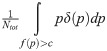
Stimuli and visual filters.a) Examples of RGB natural color images from the database. b) Set of N = 50 filters obtained after digitizing to 1 bit the luminance (L+M) coordinate. The actual bandwidth occupancy of the set (1Ntot∫f(p)>cpδ(p)dp) turns out to be slightly higher (0.06) than the imposed limit W (0.05). c) Set of N = 50 filters obtained after digitizing to one bit the l (L/(L+M)) coordinate. The actual bandwidth occupancy of the set out to be slightly higher (0.06) than the imposed limit W (0.05), but is still the same as the actual bandwidth of the 1 bit luminance set. d) Two gray-levels luminance sketches obtained with the filters in (b). e) Color-only sketches obtained with the filters in (c). f) Set of N = 50 filters obtained after digitizing to 2 bit the luminance coordinate. The actual bandwidth occupancy of the set turns out to be slightly higher (0.07) than the imposed limit W (0.05). g) Set of N = 50 filters obtained after digitizing to 1 bit both l (L/(L+M)) and luminance (L+M) coordinates. The actual bandwidth occupancy of the set turns out to be slightly higher (0.07) than the imposed limit W (0.05), but is still the same as the actual bandwidth of the 2 bits luminance set. h) Four gray-levels luminance sketches obtained the set of filters in (f). i) Color sketches obtained with the set of filters in (g).